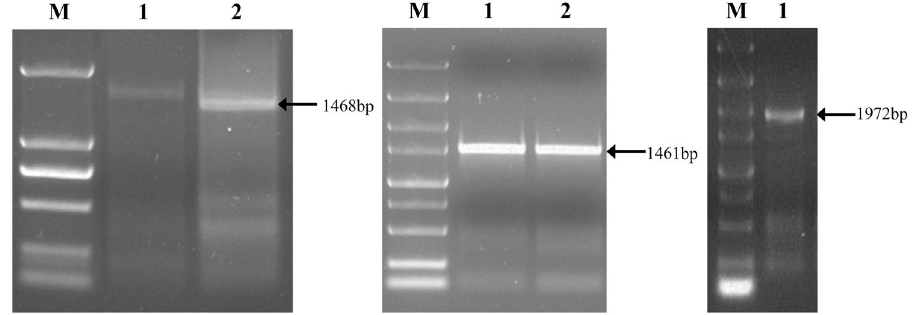
Figure 1. PCR amplification of Radopholus similis Rs - scp - 1 . ( A ) 5 ′ RACE amplification. M: DS2000 marker; 1: first-round RACE product; 2: nested PCR product. ( B ) ORF amplification. M, DS5000 marker; 1: product of Rs - scp - 1 ORF amplification. ( C ) Rs - scp gDNA amplification. M, DS5000 marker; 1: product of Rs - scp - 1 gDNA amplification.